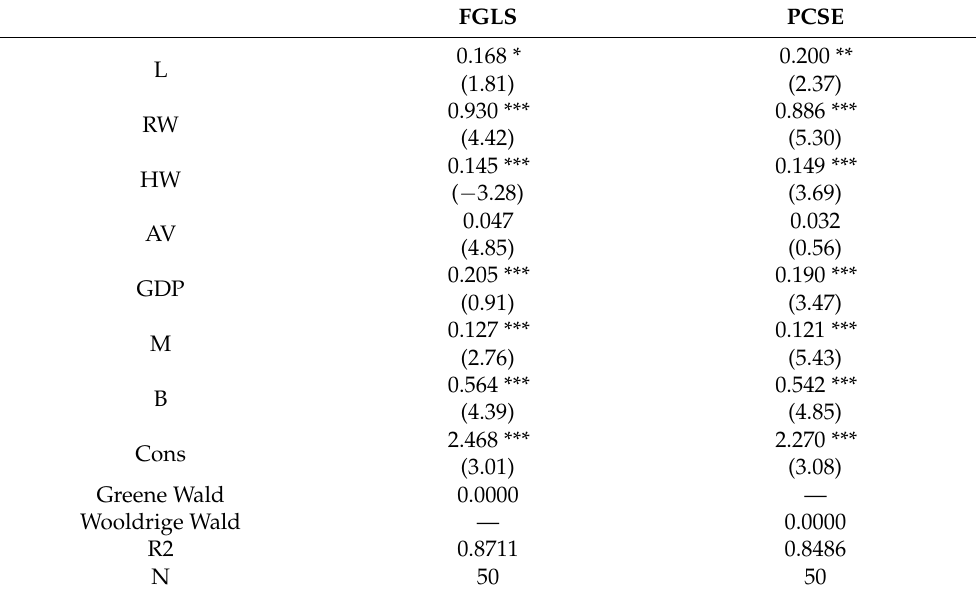
Table 6. Robustness